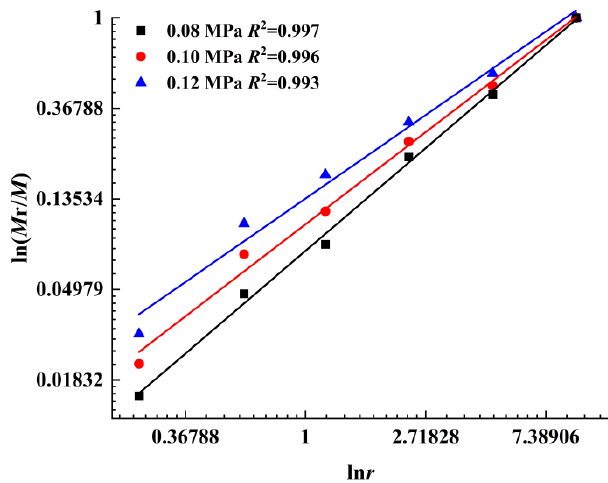
Figure 10. Variations of fragmentation degree under different impact pressures.